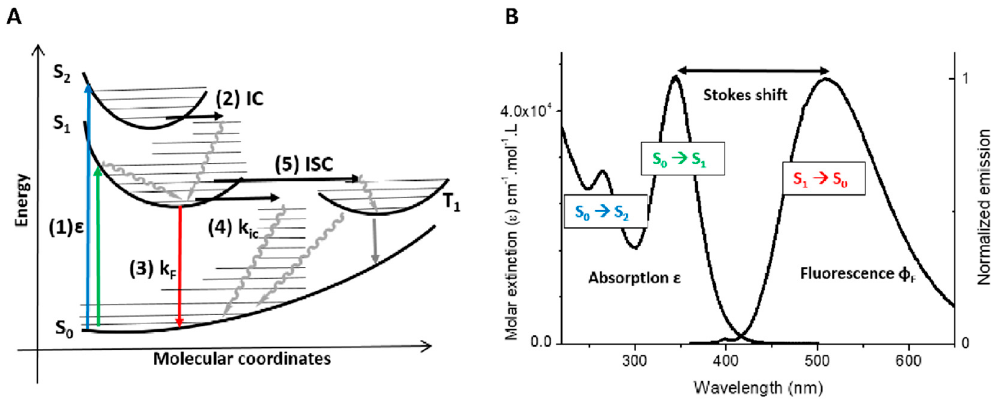
Figure 2. Photophysical parameters for fluorescent organic probes. ( A ) Perrin–Jablonski diagram containing three singlet states S0, S1, S2 and a triplet state T1. ( B ) UV–visible absorption and emission spectra. Molecular coordinates refer to molecular conformational evolution occurring during photophysical processes. ε molar extinction, IC internal conversion, ISC intersystem crossing, k F fluorescence rate constant, k ic internal conversion rate constant, φ F fluorescence quantum yield.